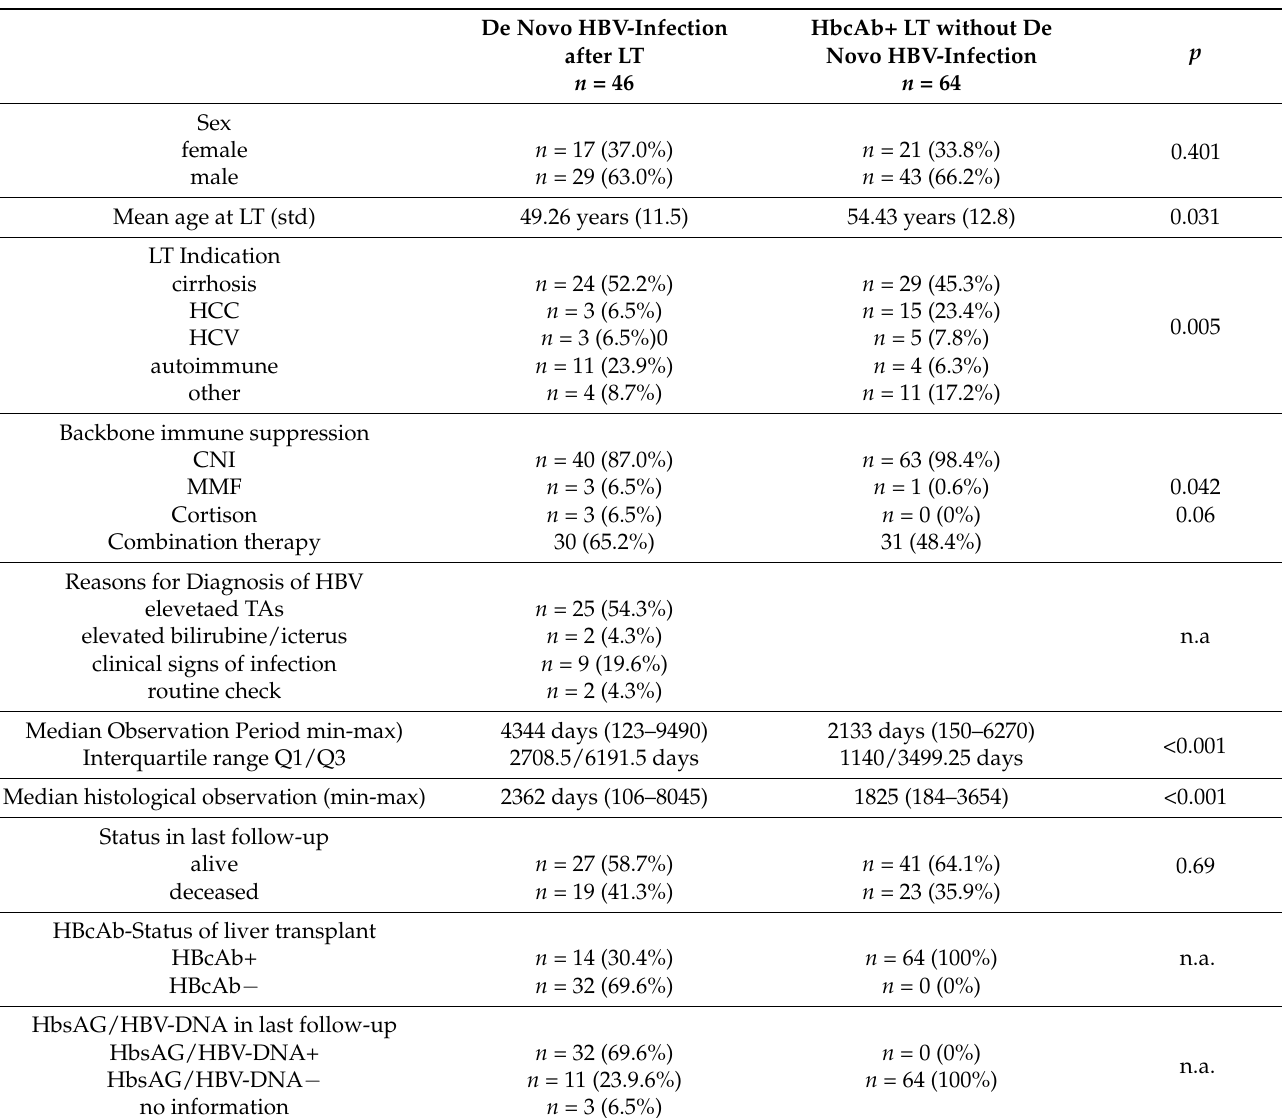
Table 1. Patient collectives and general